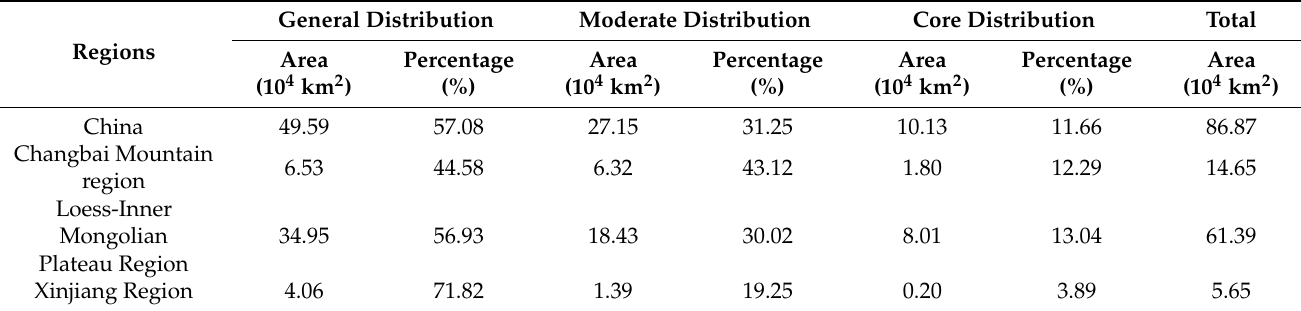
Table 2. Summary of the area and proportion of various suitable distribution areas of J. rigida in China and three regions.